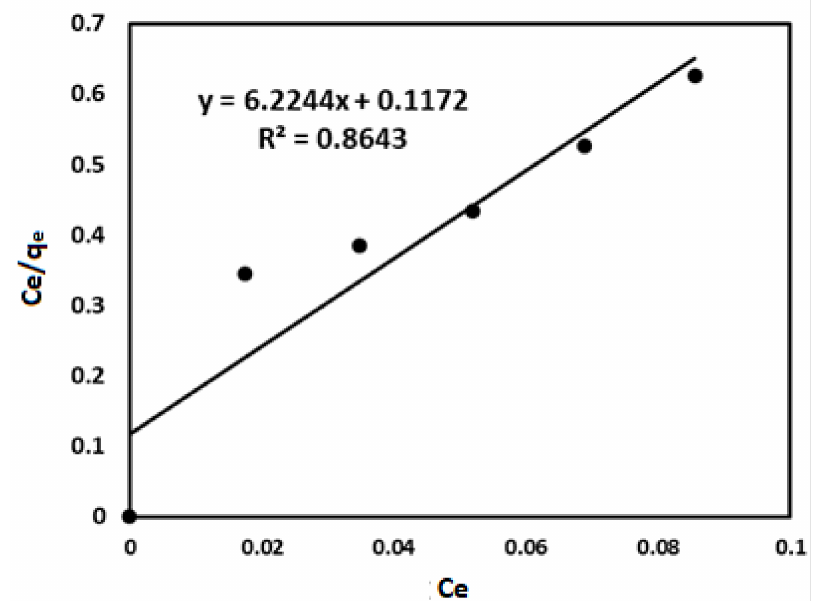
Figure 13. Langmuir isotherm on boron adsorption onto nano-magnetite at pH 8, dosage 0.5 g, contact time 240 min, and initial boron concentration 50